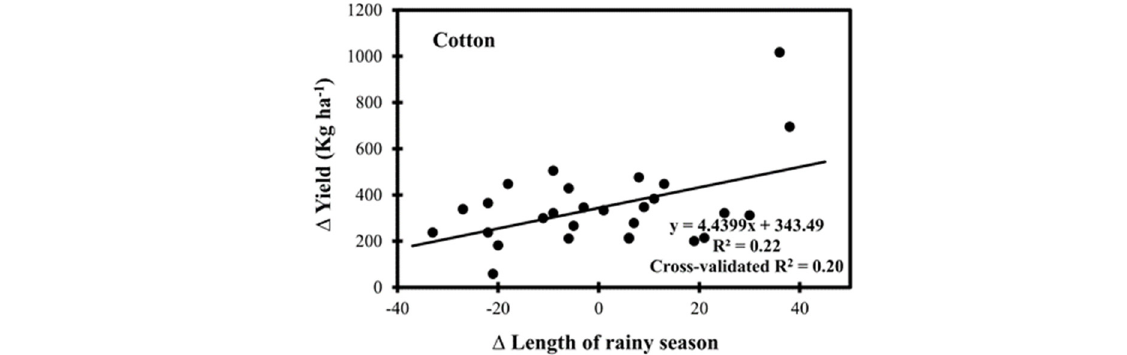
Figure 7. Relationships between the length of the rainy season and yield of five major crops grown in Gedaref state, Sudan. R 2 is coefficient of determination.